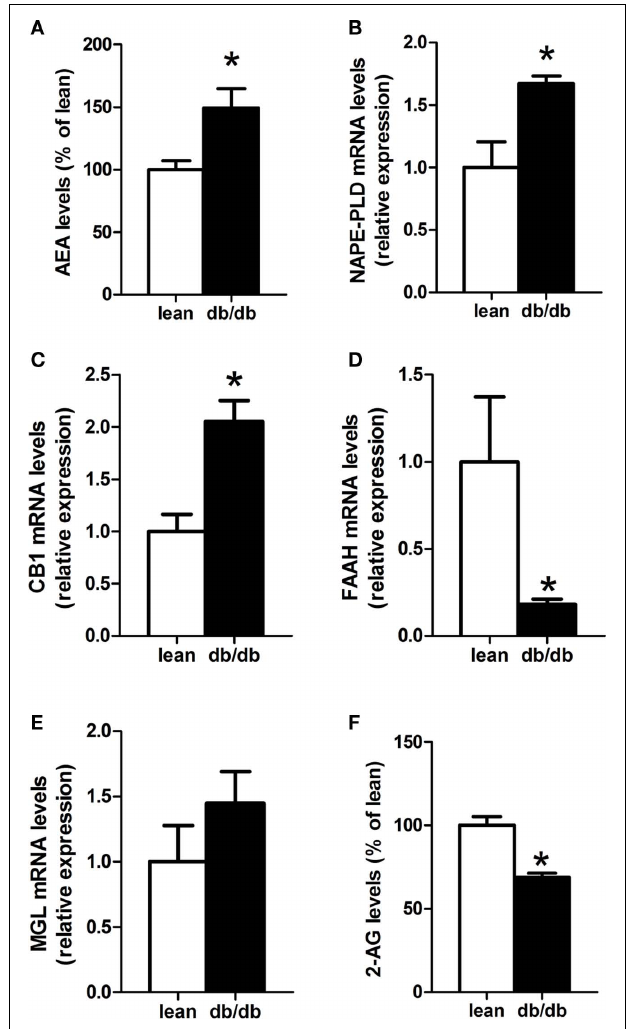
FIGURE 3 | Higher endocannabinoid system tone in the adipose tissue of db / db mice. (A) AEAtissue content (% of lean), (B) NAPE-PLD, (C) CB 1 , (D) FAAH; (E) MGL mRNA expression, and (F) 2-AG tissue content (% of lean) measured in adipose tissue. Mean ± SEM, n = 6/group, * P < 0.05 determined by a two-tailed Student’s t -test.